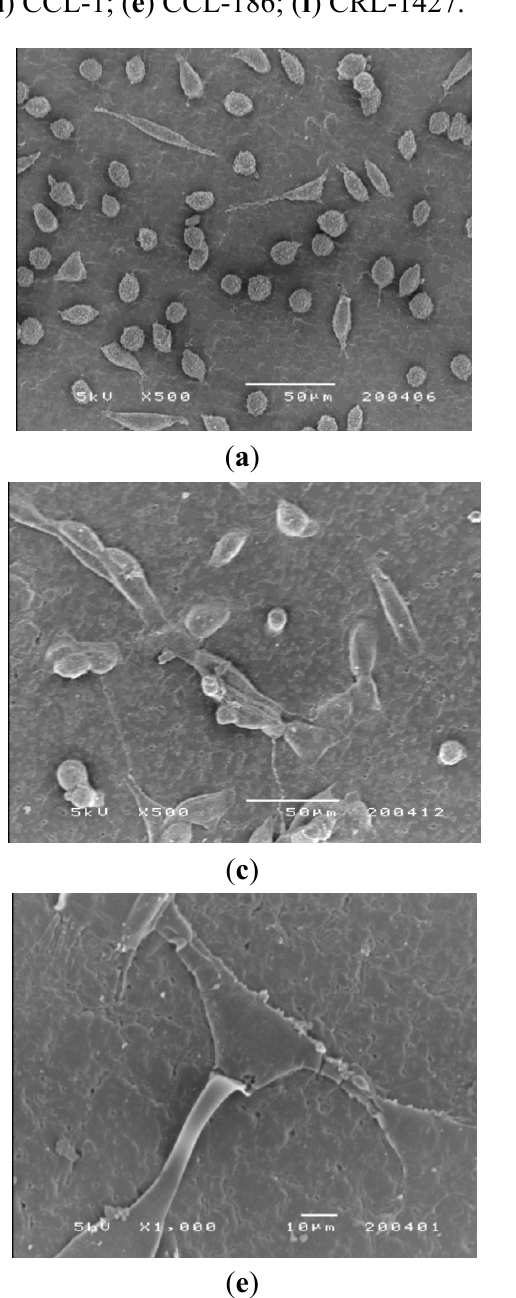
Figure 10. SEM photomicrographs of the morphology of CCL-1, CCL-186 and CRL-1427 cells cultured on the CM-hydrogel. Day 2: ( a ) CCL-1; ( b ) CCL-186; ( c ) CRL-1427. Day